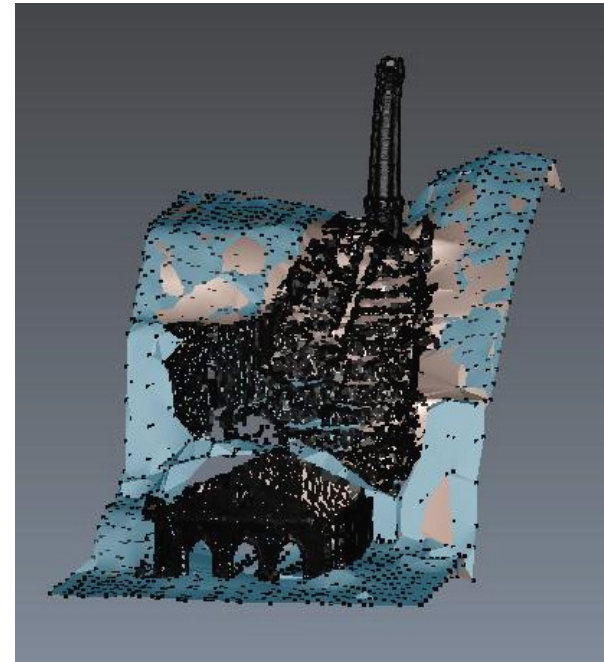
Figure 4: Combination of the own point cloud with that of LIDAR (source: prepared by the